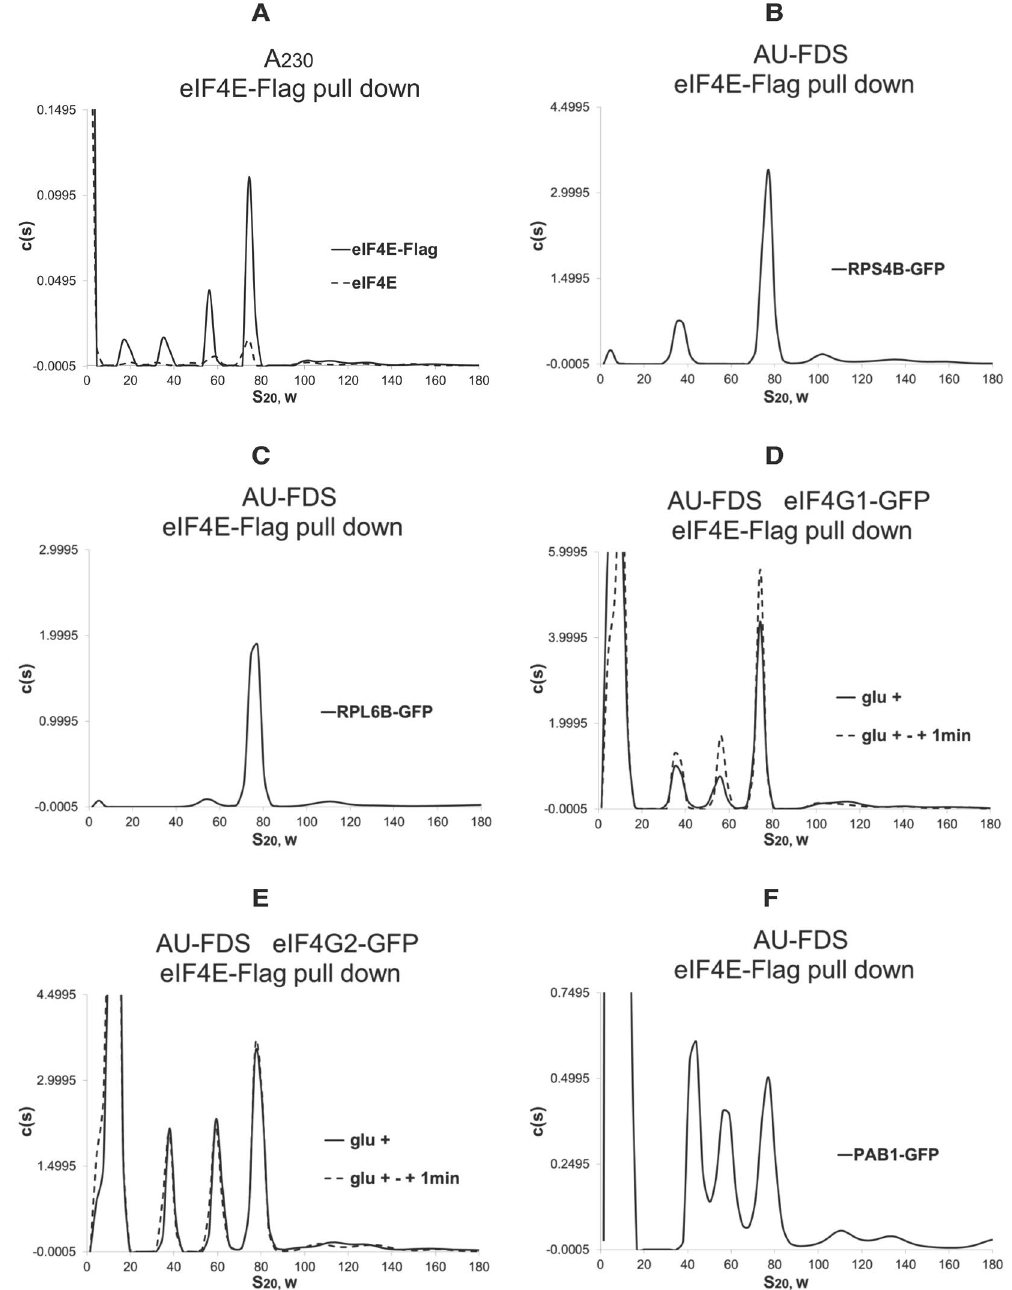
Figure 2. AUC analysis following eIF4E-Flag purifications. AUC analyses were conducted as described in Fig. 1 except eIF4E-Flag pull downs were conducted 25 . ( A ) AU-A 230 analysis displaying eIF4E-Flag pull down as compared to an isogenic strain lacking eIF4E-Flag. ( B – F ) AU-FDS analyses were conducted on the GFP tag proteins as indicated under the conditions